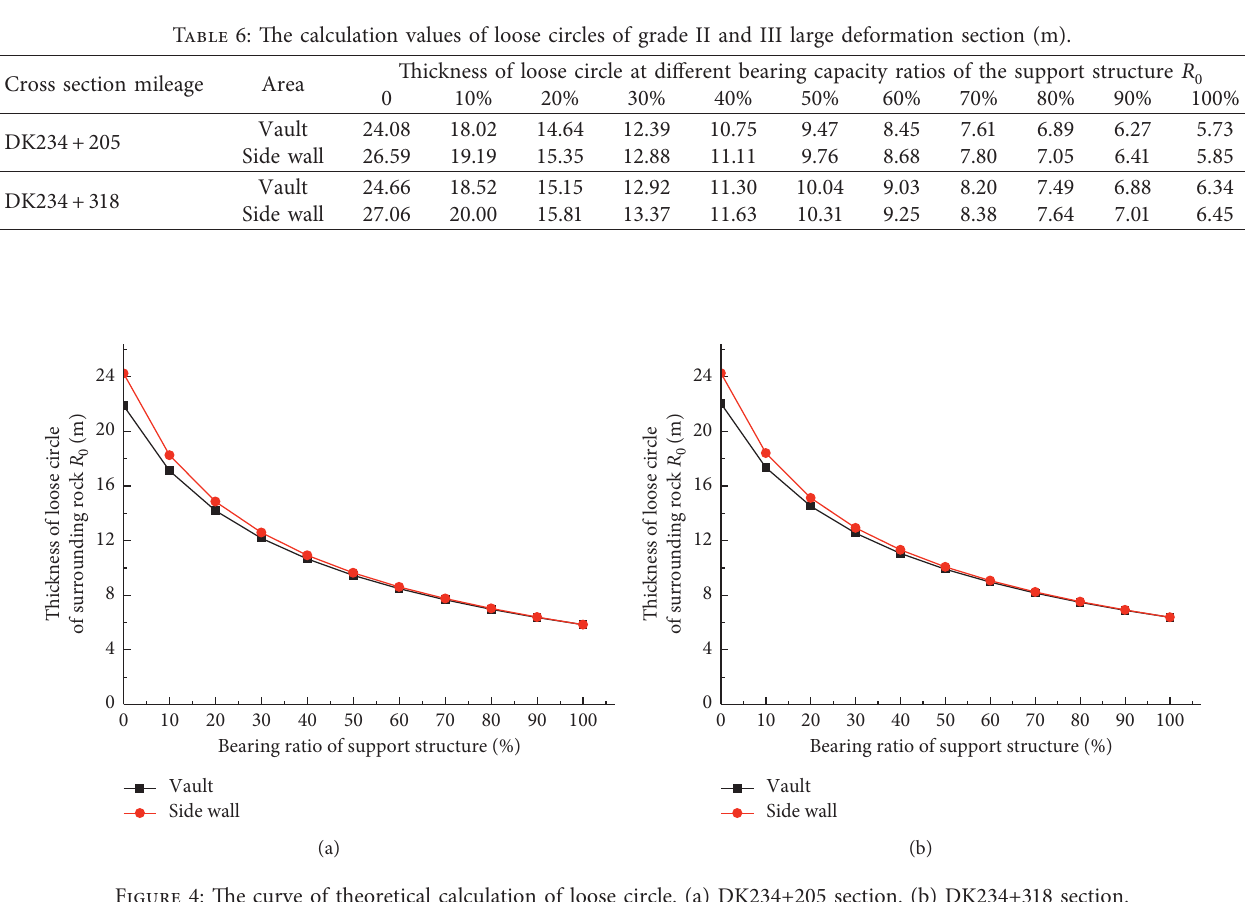
Figure 4: The curve of theoretical calculation of loose circle. (a) DK234+205 section. (b) DK234+318 section.